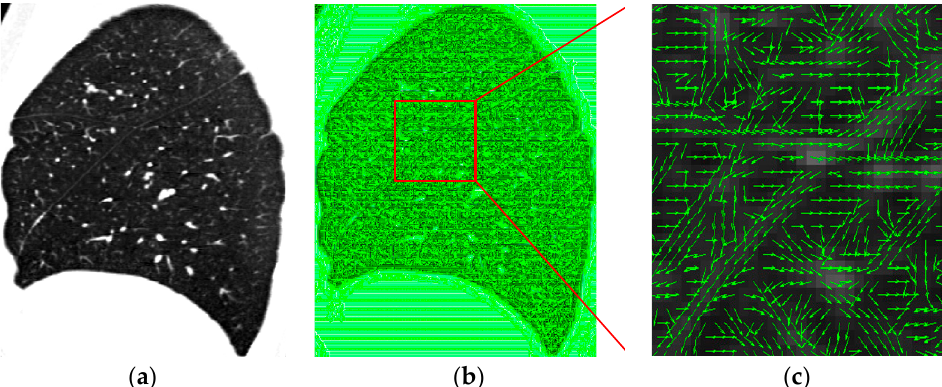
Figure 2. The orientation response of an oriented derivative of stick (ODoS) filter: ( a ) original image, ( b ) vector filed, ( c ) zoomed image of the red rectangle region in ( b ).